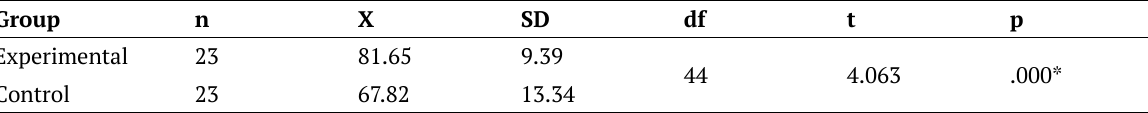
Table 4. Comparisons of pre-and post-test scores of experimental and control groups Group